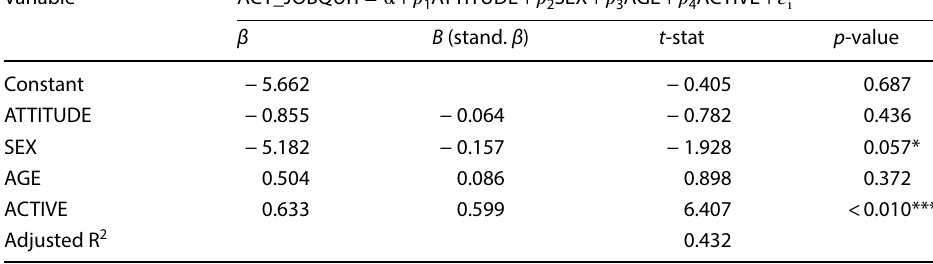
Table 6 Results of the regression analysis for the impact of attitudes towards frequent job-quitting behaviour on career starters’ actual